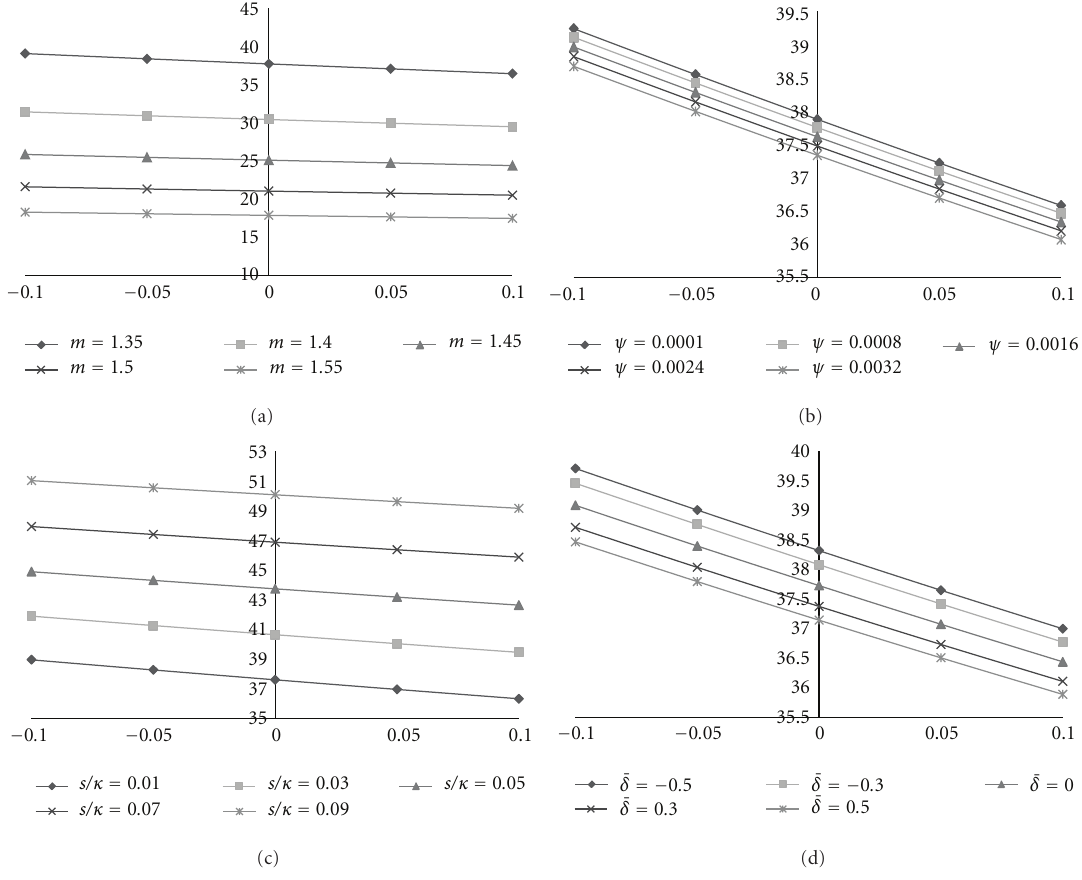
Figure 5: (a)–(d) Variation of load-carrying capacity with respect to ε and m , ψ , s/κ , δ .